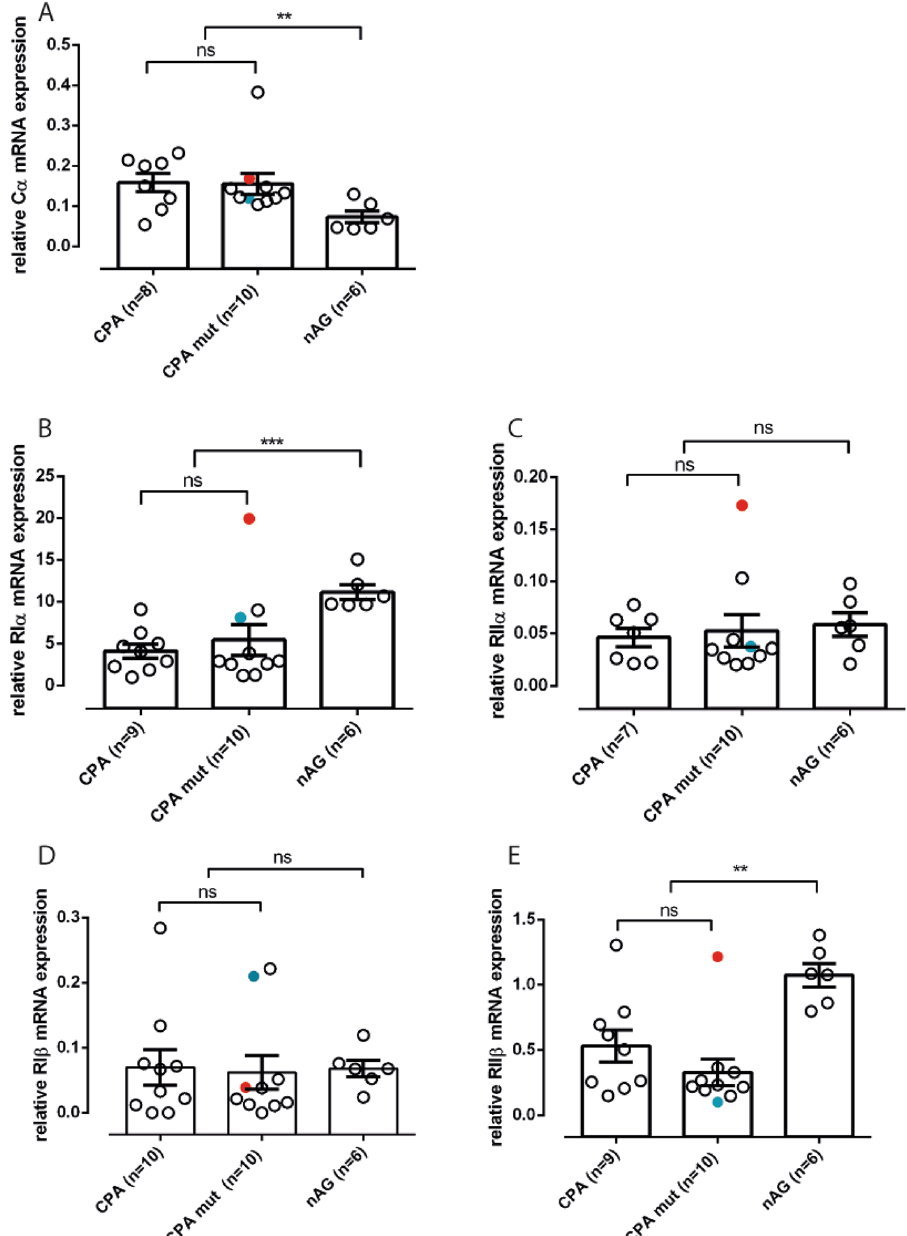
Figure 3. PKA subunits mRNA expression on CPA. Relative PKA subunits mRNA expression (normalized to β -actin using the Δ CT method 30 ) for PRKACA ( A ), PRKAR1A ( B ), PRKAR2A ( C ), PRKAR1B ( D ) and PRKAR2B ( E ). The non-parametric Mann-Whitney-U Test was performed to identify statistical differences between CPA (combined CPA PRKACA mutated and non mutated) and normal adrenal glands (nAG). Red dot: p.245_248del mutation in PRKACA , blue dot: p.W197R PRKACA